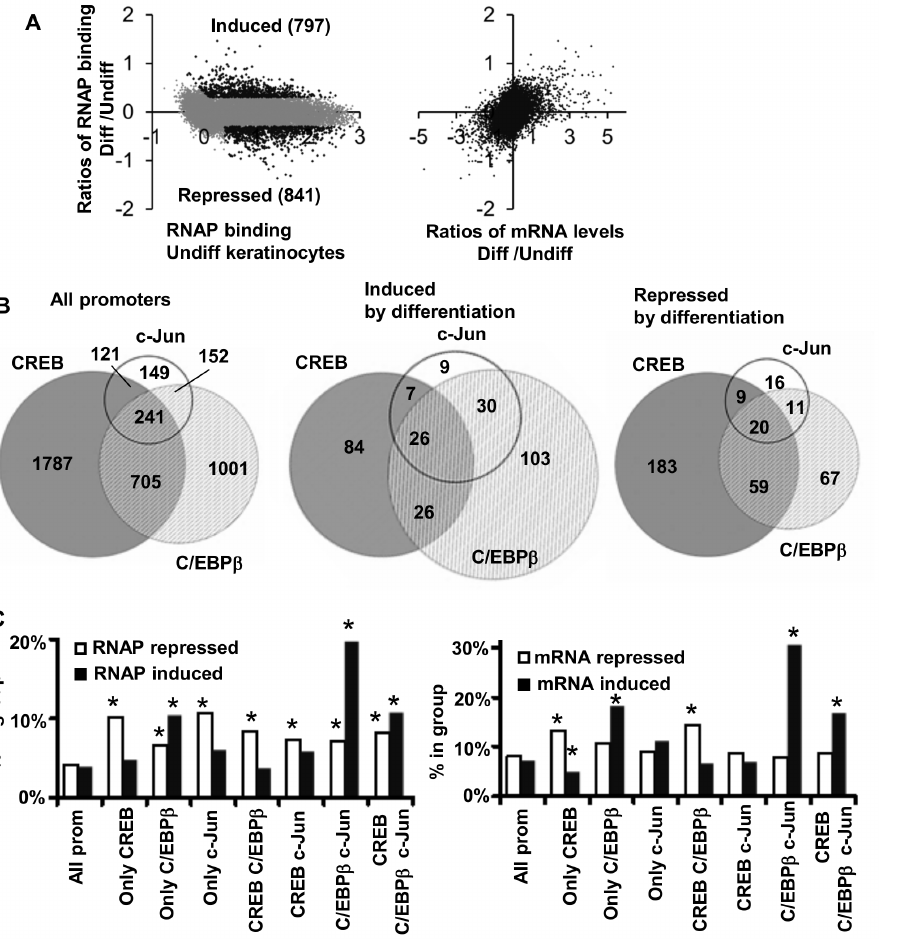
Figure 1. Upon keratinocyte differentiation RNAP binding and mRNA levels are preferentially induced when promoters are bound by combinations of C/EBP b and cJun. A. Scatterplott of changes in RNAP binding after differentiation versus RNAP binding in undifferentiated keratinocytes show 797 and 841 promoters are induced or repressed upon differentiation. These changes correlate with changes in mRNA levels. B. Transcription factors CREB, C/EBP b and c-Jun bind distinct set of promoters in differentiated keratinocytes. Euler diagrams show that promoters bound by C/EBP b and c-Jun are preferentially induced by differentiation and promoters bond by CREB are not. C. Fraction of promoters bound by different combination of transcription factors in differentiated keratinocytes where RNAP binding is repressed (white bars) or induced by differentiation (black bars). D. Fraction of genes with mRNA levels induced or repressed by differentiation more than 1.4 times in groups of promoters bound by different combinations of transcription factors. * - values are different from expected (p , 0.005 using a two-tailed unpaired t- test).